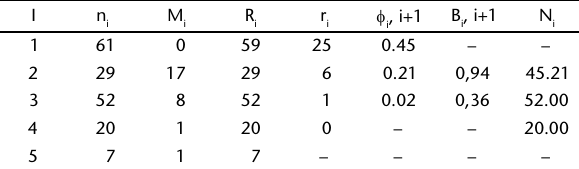
Table I. Numbers of captured individuals (n recaptured